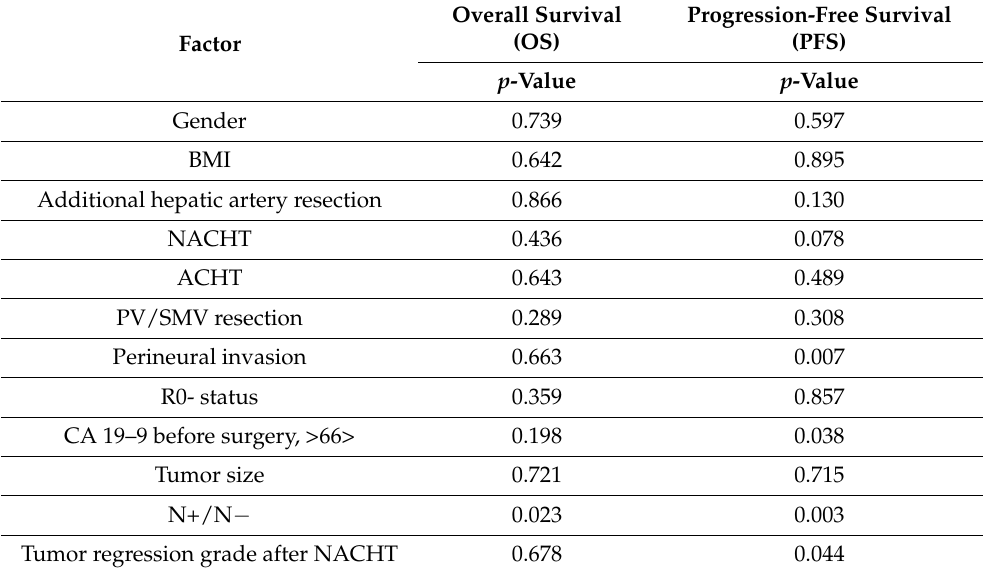
Table 4. Significance of perioperative factors for survival of patients with PDAC.